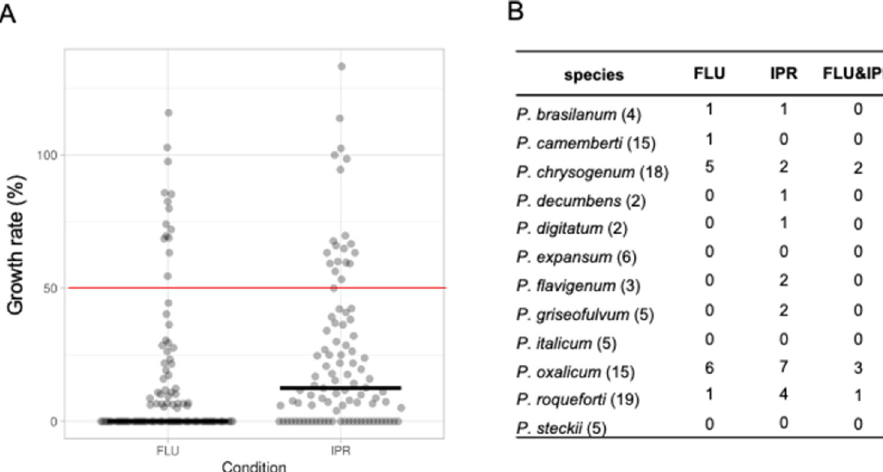
Fig 1. Multi-drug resistance to fludioxonil and iprodione. (A) Box plots showing the growth rates of 99 Penicillium strains in the presence of fludioxonil (FLU) and iprodione (IPR). The plots for growth rates � 50% indicate resistant strains. (B) The number of fludioxonil and/or iprodione-resistant strains. Numbers in parentheses indicate the total number of